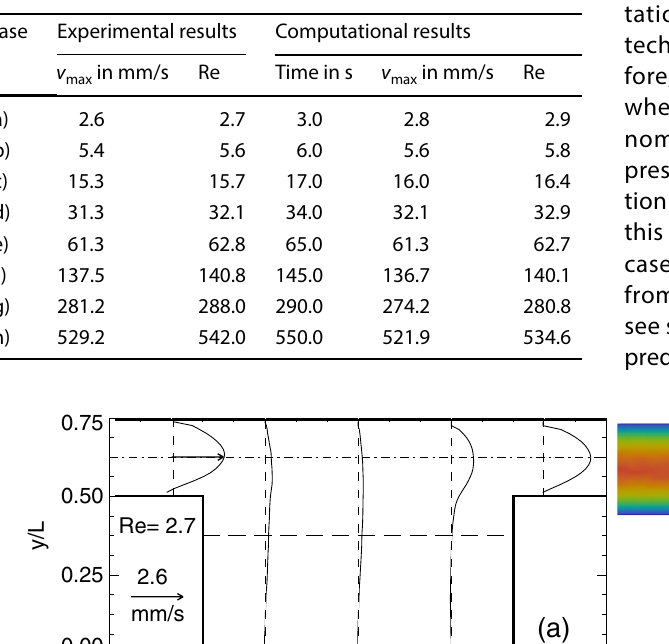
Table 2 Choice of time values for comparison, the experimen- tal results are obtained from the PIV data, and maximum velocity is calculated in experimental as well as computational data at the same location, v